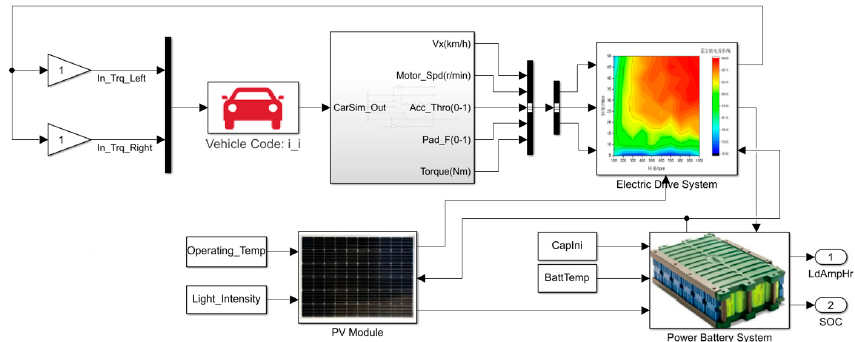
Figure 7. Simulink simulation model of the whole vehicle.